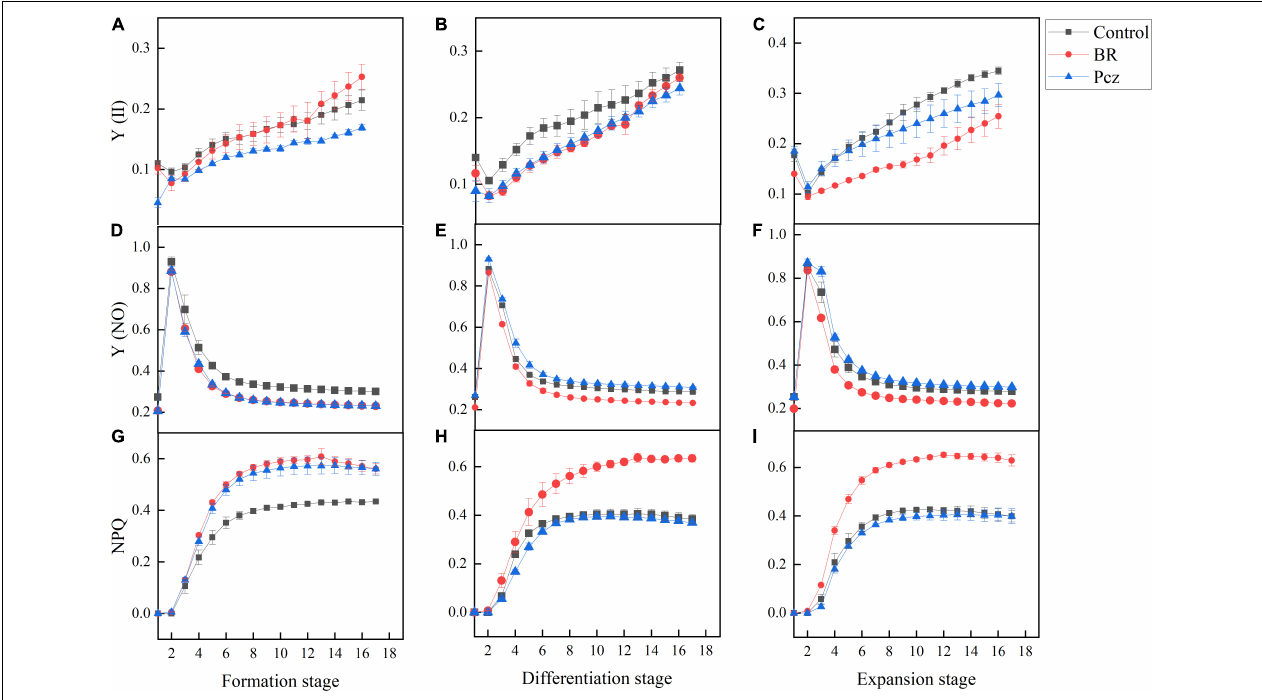
FIGURE 5 | Chlorophyll fluorescence kinetic curves of P. ternata under BR and PCZ treatment. (A–C) Time-response of Y (II) at formation stage, differentiation stage, and expansion stage. (D–F) Time-response of Y (NO) at formation stage, differentiation stage, and expansion stage. (G–I) Time-response of NPQ at formation stage, differentiation stage, and expansion stage. Values are means of four replicates ±